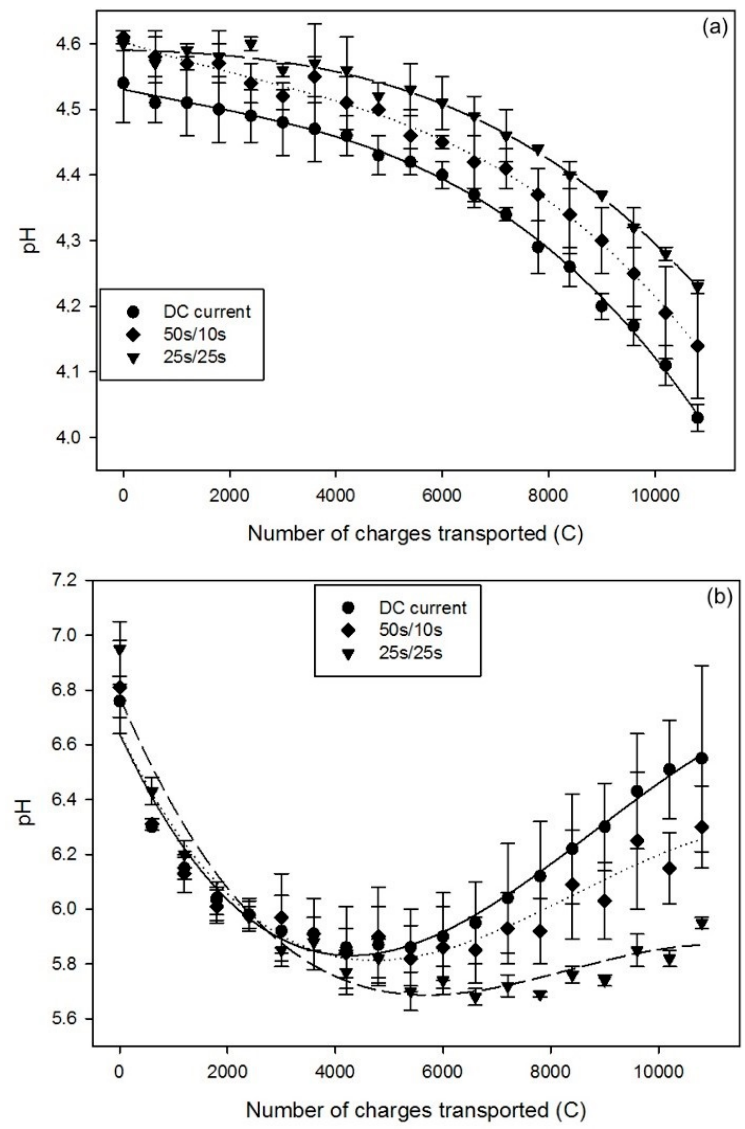
Figure 2. pH evolution for DC (dots), PEF 50 s/10 s (rhombuses), and PEF 25 s/25 s (inverted triangles) current conditions in ( a ) AWComp and ( b ) OAComp.